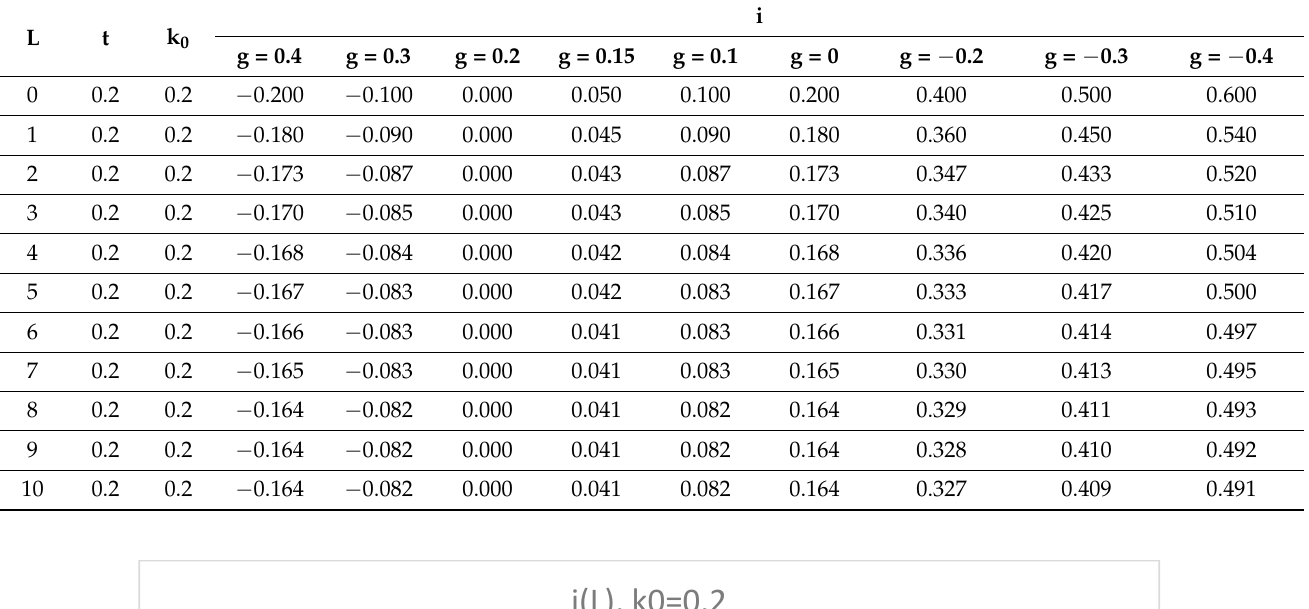
Table 3. Dependence of discount rate i on leverage level L in Generalized Modigliani–Miller theory (GMM theory) at